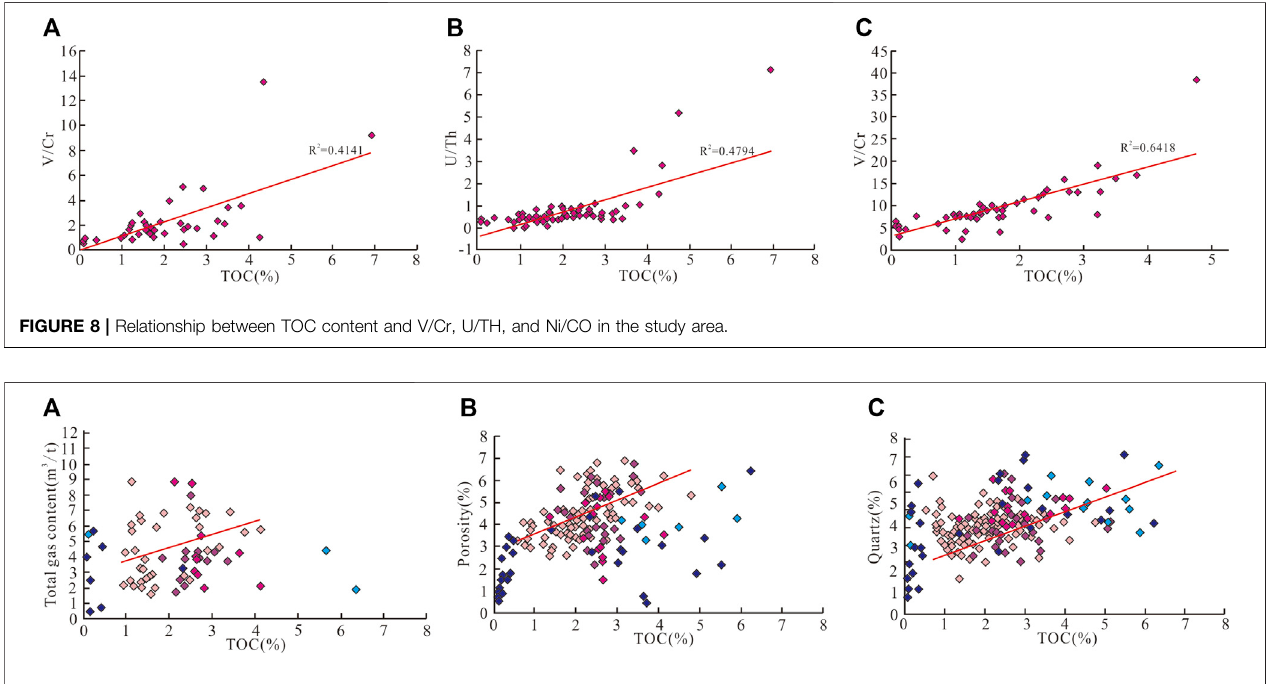
FIGURE 9 | Relationships between TOC content and porosity, gas volume, and quartz in the study area.